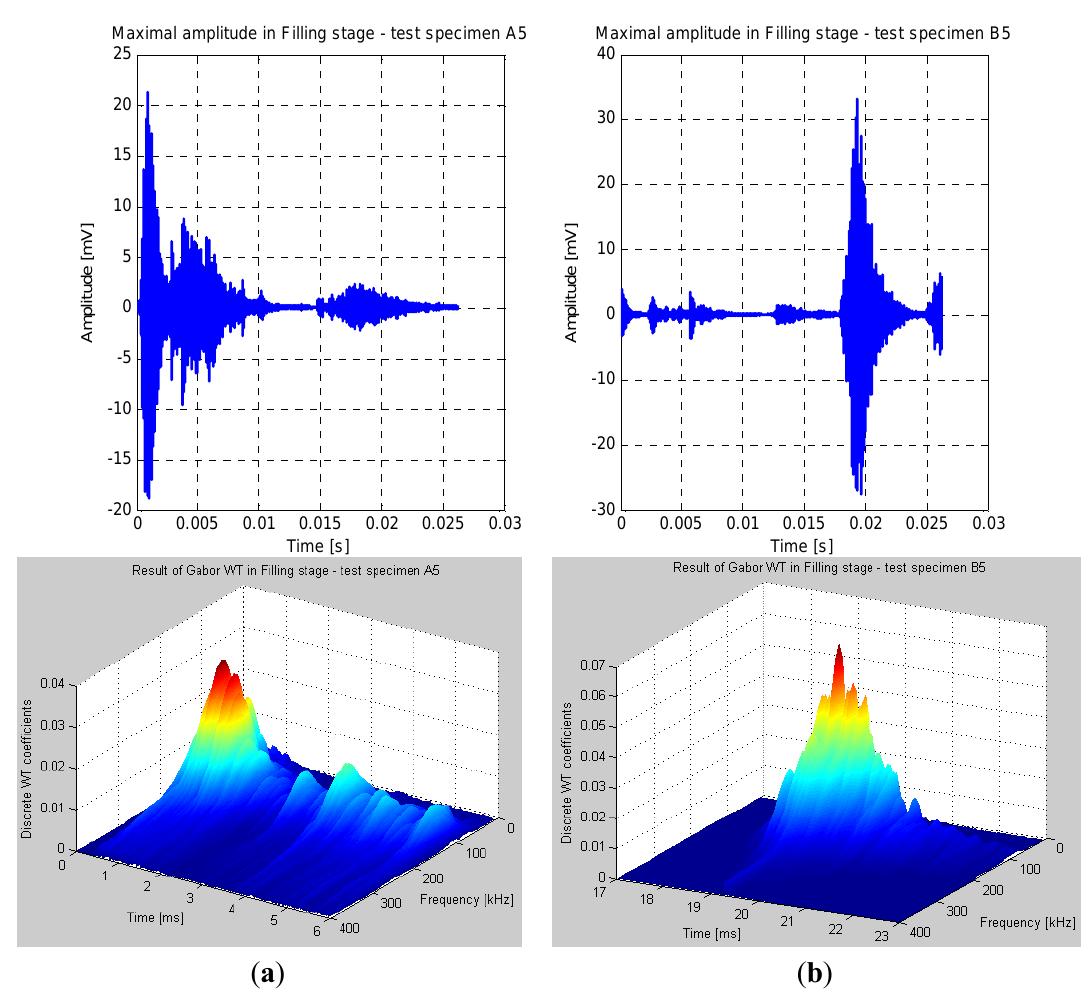
Figure 6. Maximal amplitudes and Gabor wavelet result during the filling stage. ( a ) Test specimen A5 (new engraving insert); ( b ) Test specimen B5 (used engraving insert with